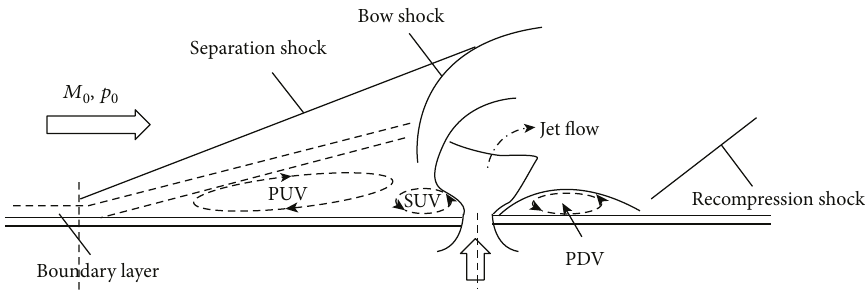
Figure 1: Structure of nozzle fl ow fi eld with SITVC